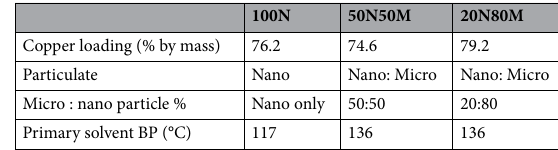
Table 1. Copper ink